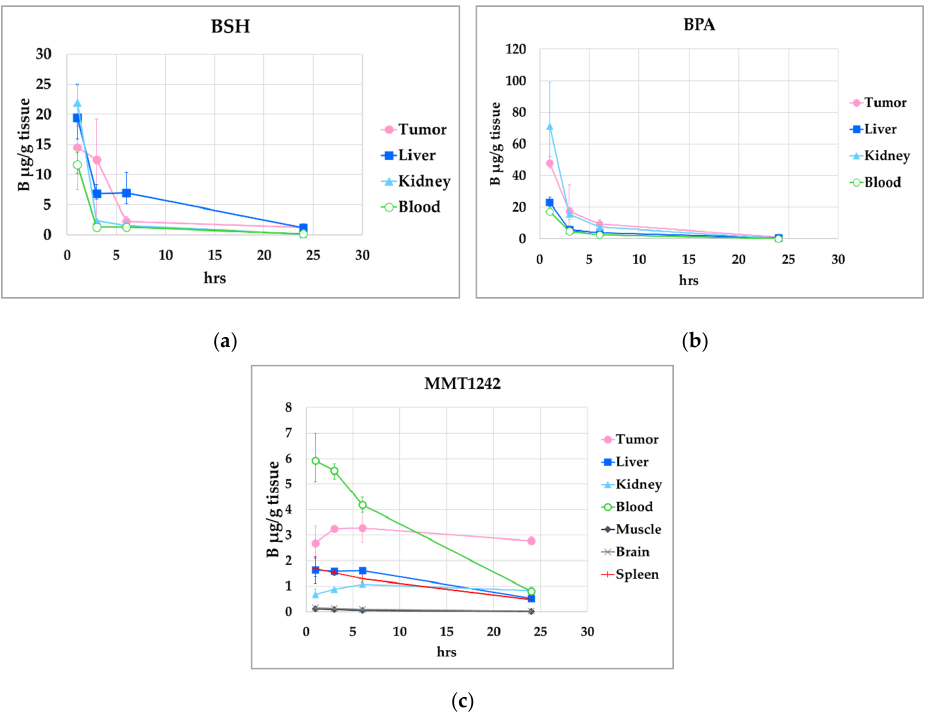
Figure 8. The biodistribution of MMT1242 in mice tumor models. Higher tumor-to-blood ratio as seen 24 h after injection of MMT1242 ( c ) compared with BPA ( b ) or BSH ( a ).